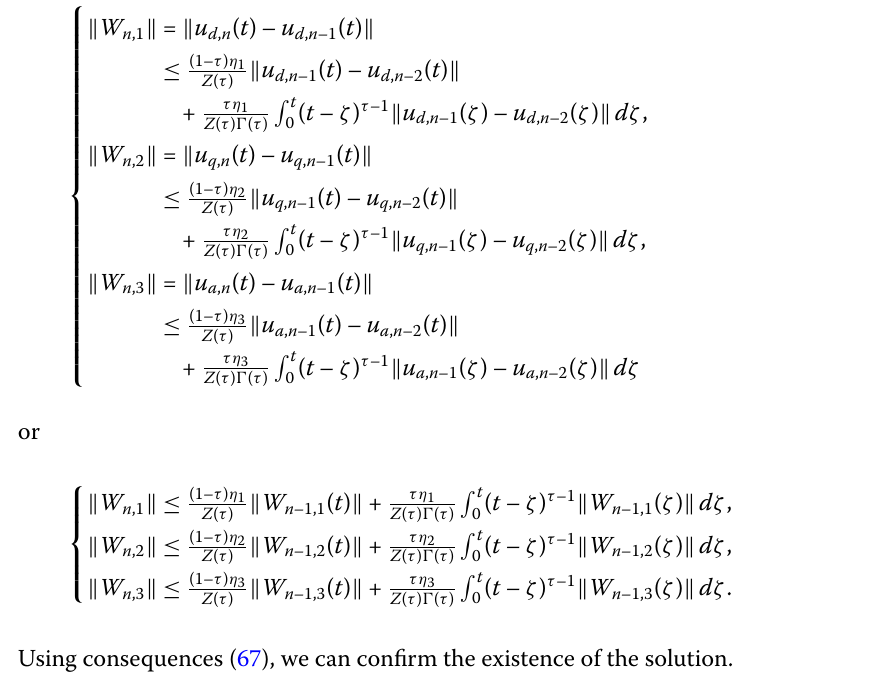
Let the difference between successive components of system (65) be denoted by W ( n , i ), i = 1,2,3. Then from system (65) and the kernel equations satisfying the Lipschitz condi- tion we